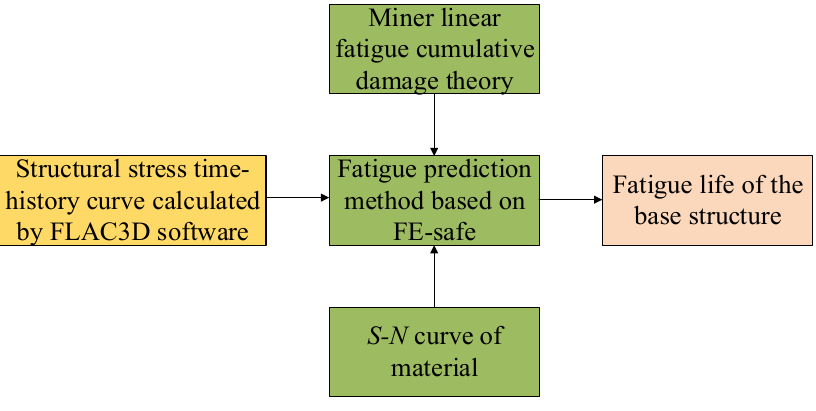
Figure 16. Fatigue life calculation process.